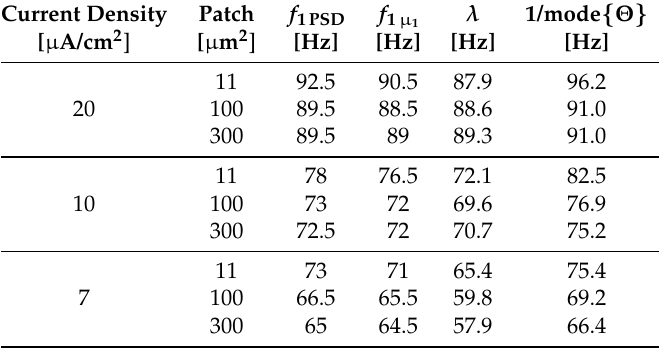
Table 1. Frequency of the first peak of Fast Fourier Transform (FFT) ( f 1PSD ), frequency of the first peak of µ 1 , mean firing rate, and inverse of interspike interval (ISI)